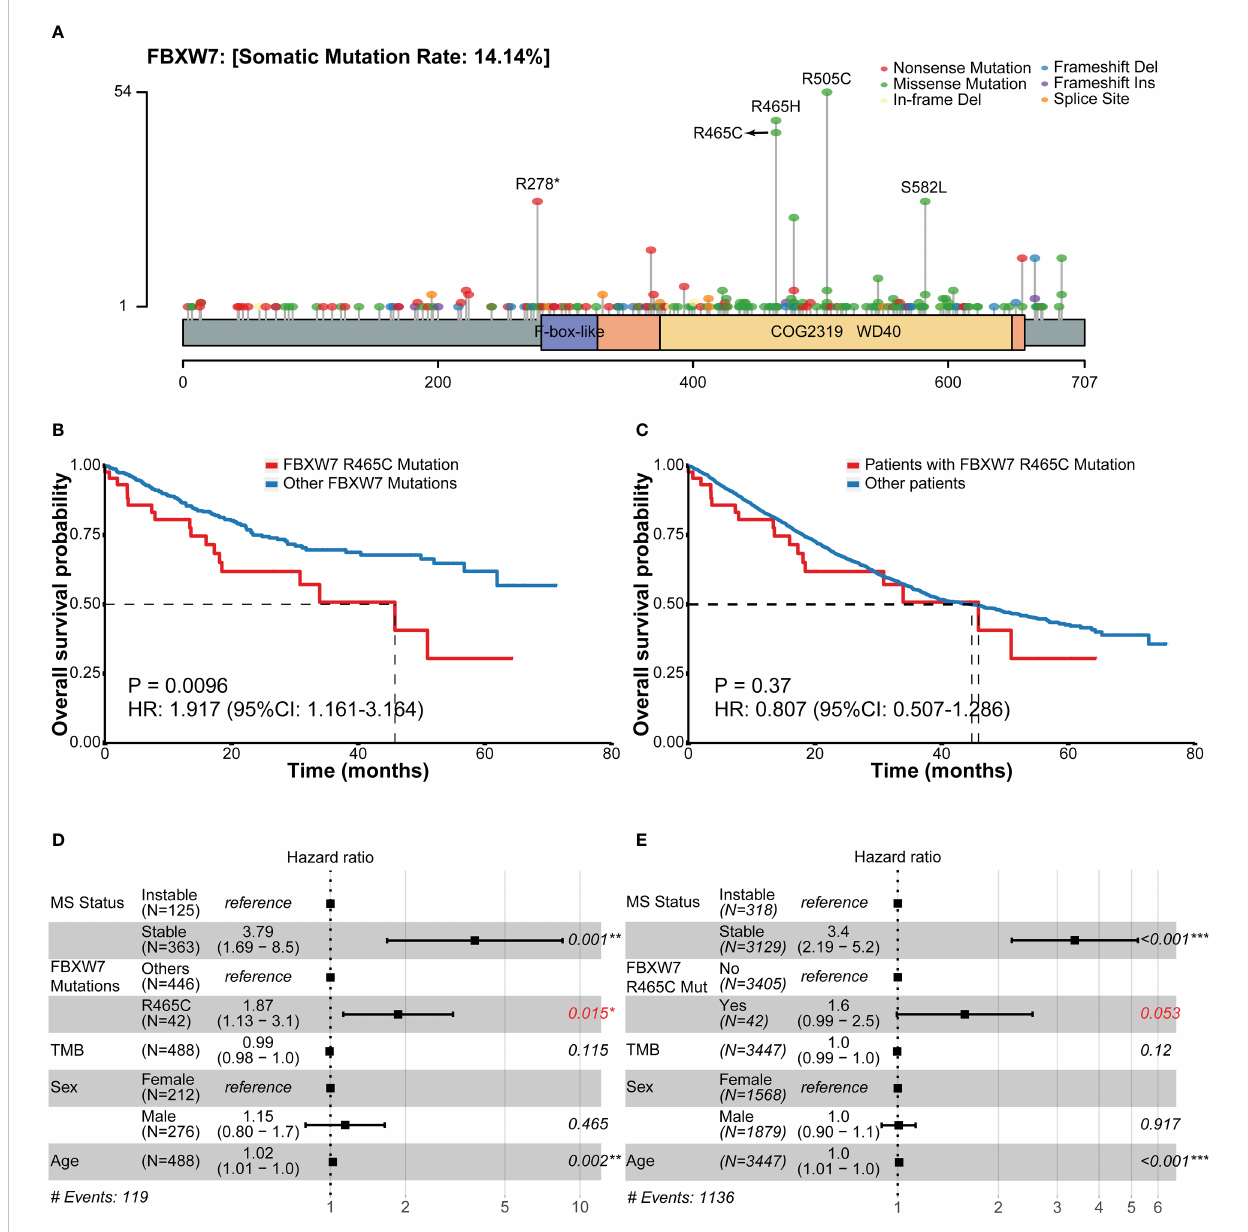
FIGURE 4 Frequencies of FBXW7 mutation sites and related overall survival outcomes in the MSK cohort. (A) Lollipop plot unveiling the mutation frequencies of each site of FBXW7; (B) Kaplan-Meier overall survival curves of between colorectal cancer patients carrying FBXW7 R465C mutations and other FBXW7 mutations; (C) Kaplan-Meier overall survival curves of between colorectal cancer patients carrying FBXW7 R465C mutations and not carrying FBXW7 R465C mutations; (D) Forest plot of overall survival regarding the MS status, FBXW7 R465C mutation status, TMB, sex, age in FBXW7-mutated patients; (E) Forest plot of overall survival regarding the MS status, FBXW7 R465C mutation status, TMB, sex, age in all patients. HR, hazard ratio; CI, con fi dential